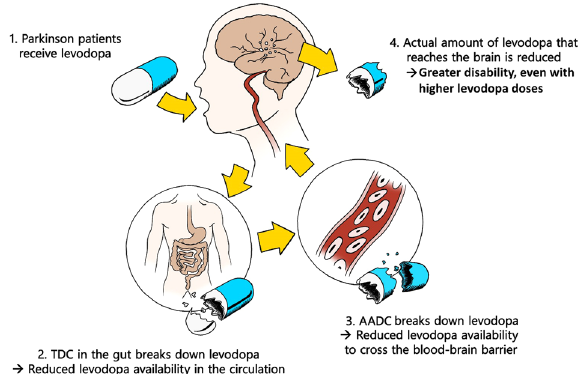
Fig. 2 The two mechanisms of peripheral levodopa resistance. TDC tyrosine decarboxylase, AADC aromatic L -amino acid